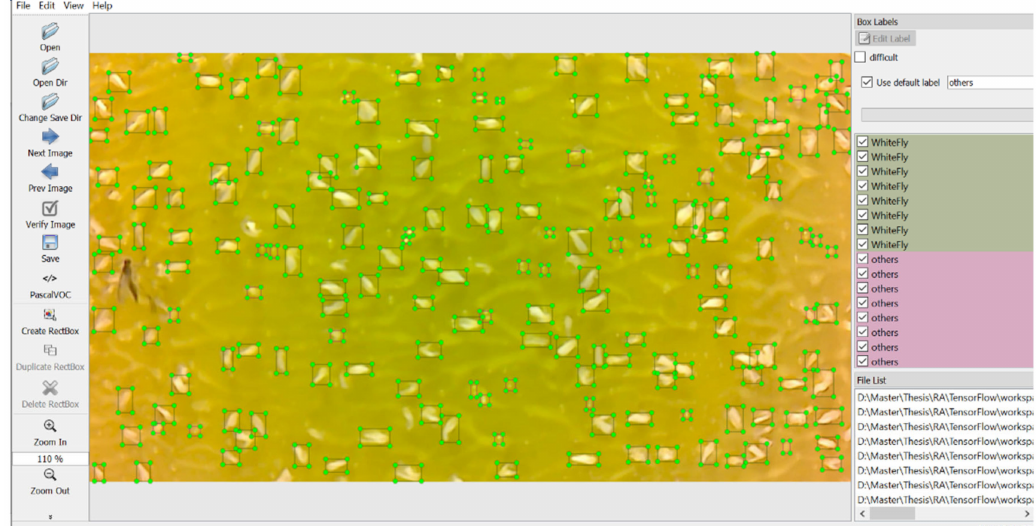
Figure 4. This figure shows the labeled image using LabelImg